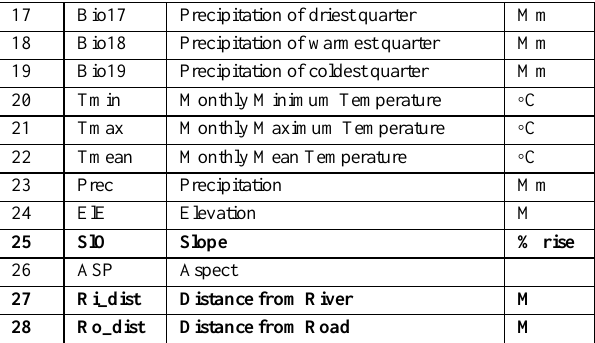
Table 1. Environmental variables used in the study *Note: The variables highlighted in bold format were the ones selected through multi-collinearity test and, then used in modeling as environmental variables. 4.